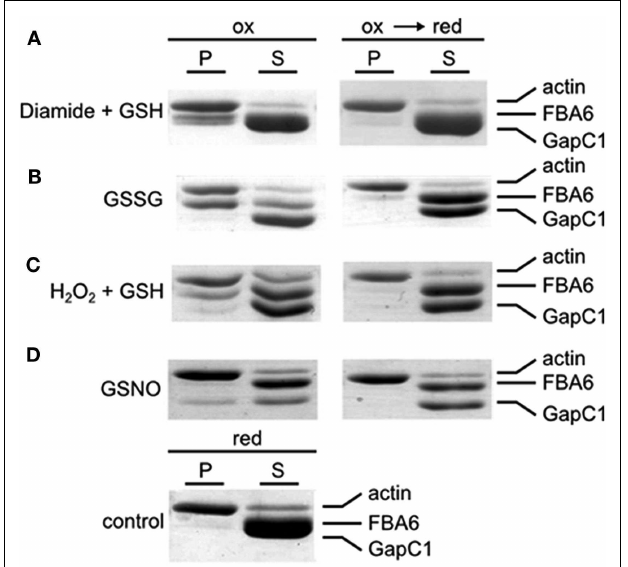
FIGURE 5 | Co-sedimentation assay with F-actin, GAPDH, and aldolase under oxidizing and reducing conditions. Samples with rabbit F-actin, FBA6, and GapC1 were first oxidized with the specific redox reagents (A) Diamide + GSH (each 0.5mM); (B) GSSG (5mM); (C) H 2 O 2 + GSH (each 0.5mM); (D) GSNO (0.5mM) with a following reduction by DTT red (10mM). The control sample with F-actin, FBA6, and GapC1 was only incubated with DTT red (10mM).The mixtures were then centrifugated at 100,000 × g for 1h. Supernatant (S) and pellet (P) were separated for analysis by SDS-PAGE and the gels were stained with Coomassie Brilliant blue.